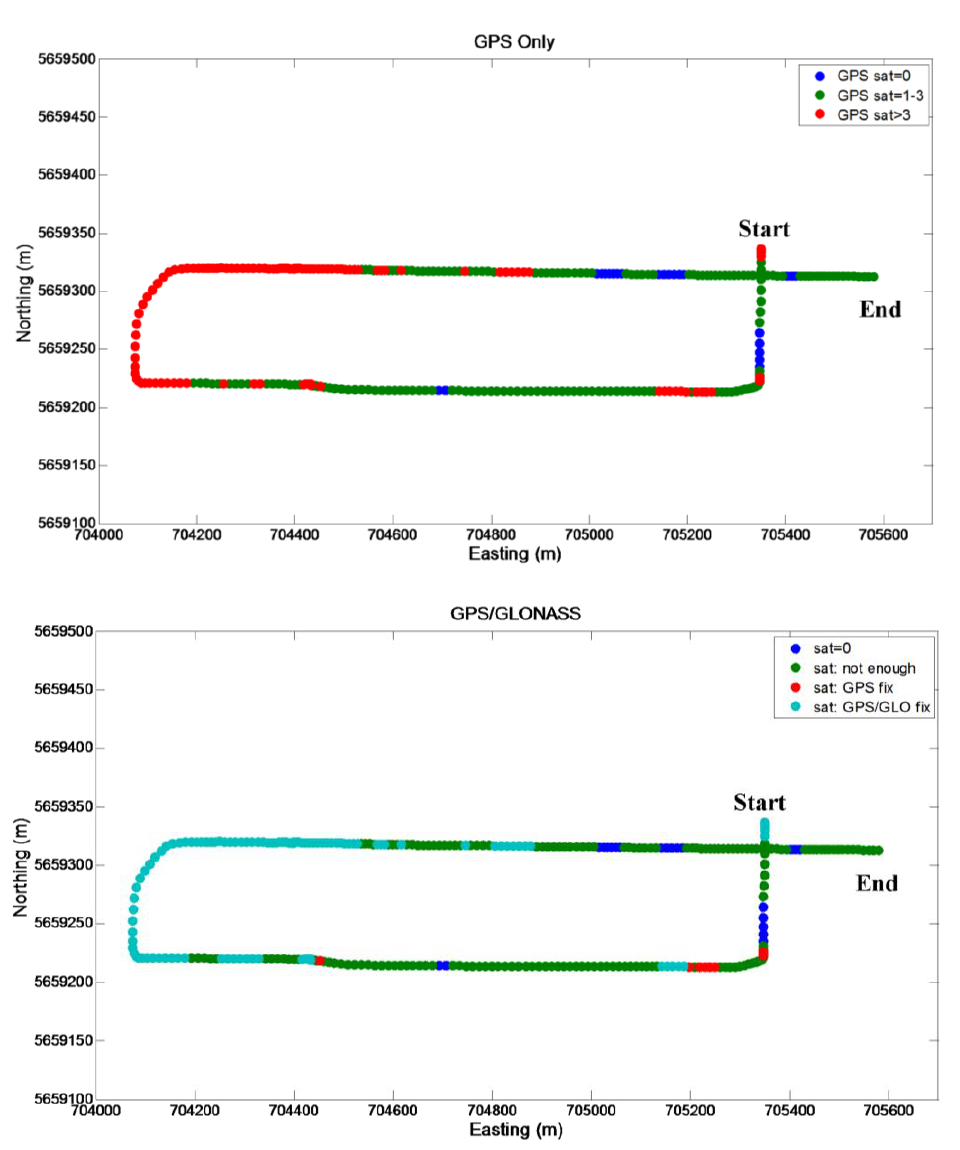
Figure 8. GNSS visibility on the Segment 2